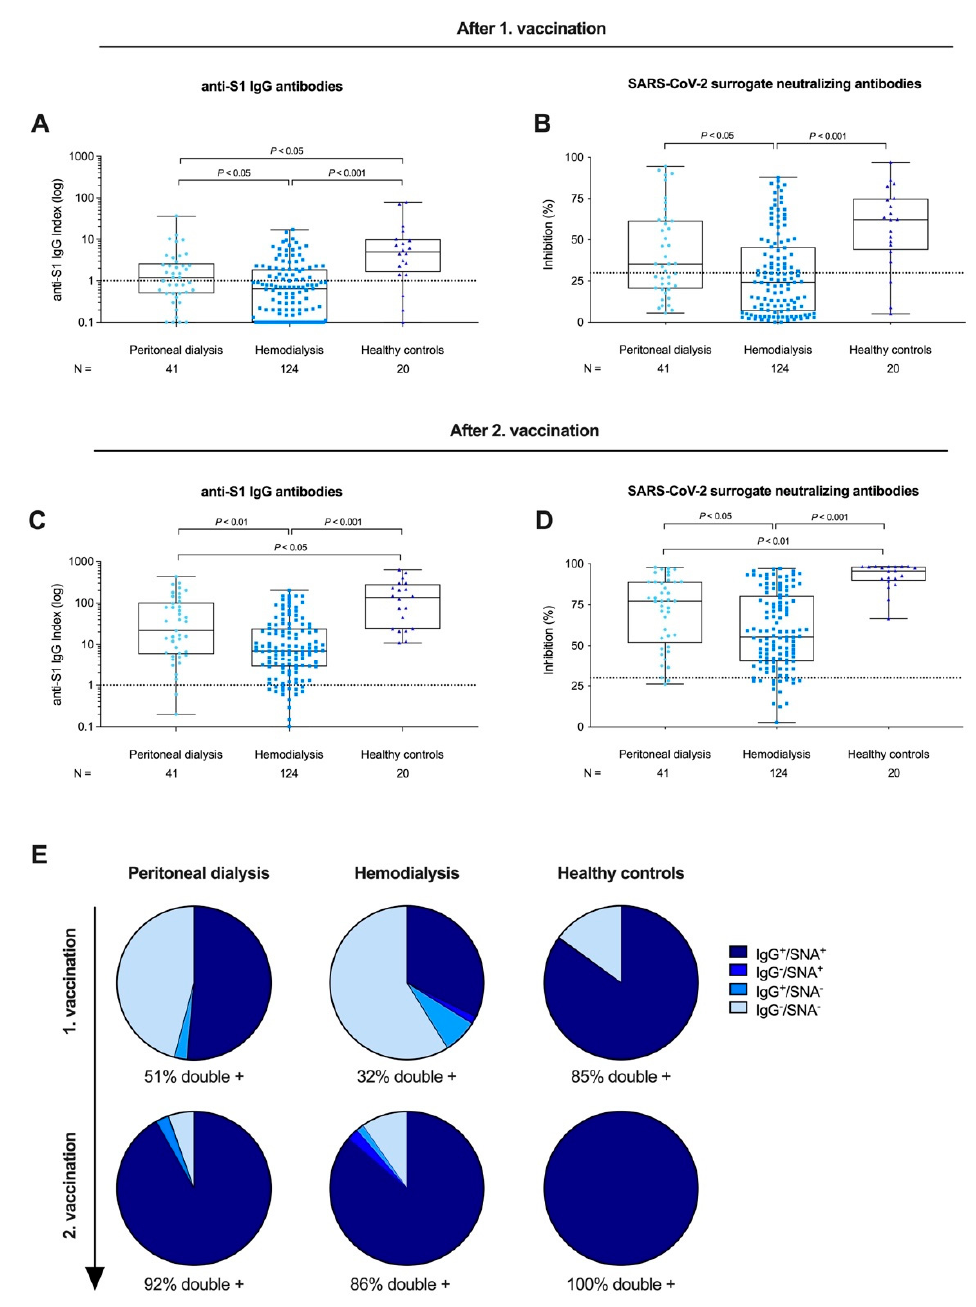
Figure 2. SARS-CoV-2 anti-S1 IgG and surrogate neutralizing antibodies (SNA) in patients receiving peritoneal dialysis, hemodialysis, and healthy controls after prime and boost vaccination with BNT162b2. Anti-S1 IgG antibodies after first (prime) vaccination are represented logarithmically as an anti-S1 IgG index for peritoneal dialysis patients, hemodialysis patients, and healthy controls ( A ). The dashed black line represents the cutoff for detection with a semi-quantitative index ≥ 1 defining positivity. SARS-CoV-2 SNA were determined by a surrogate virus neutralization test for patients receiving peritoneal dialysis, hemodialysis, and healthy controls after first vaccination ( B ). Anti-S1 IgG antibodies after second (boost) vaccination for patients on peritoneal dialysis, hemodialysis, and healthy controls. The dashed black line represents the cut-off of ≥ 30% in this assay according to the manufacturer’s instructions ( C ). Formation of SARS-CoV-2 SNA after second (boost) vaccination for patients on peritoneal dialysis, hemodialysis, and healthy controls ( D ). Seropositivity for anti-S1 IgG and SARS-CoV-2 SNA after first (prime) and second (boost) vaccination in patients on peritoneal dialysis, hemodialysis, and healthy controls presented as a pie chart ( E ).